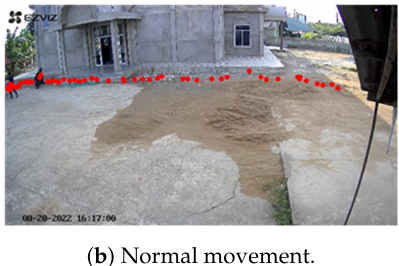
Figure 9. Example of normal and abnormal tracking.